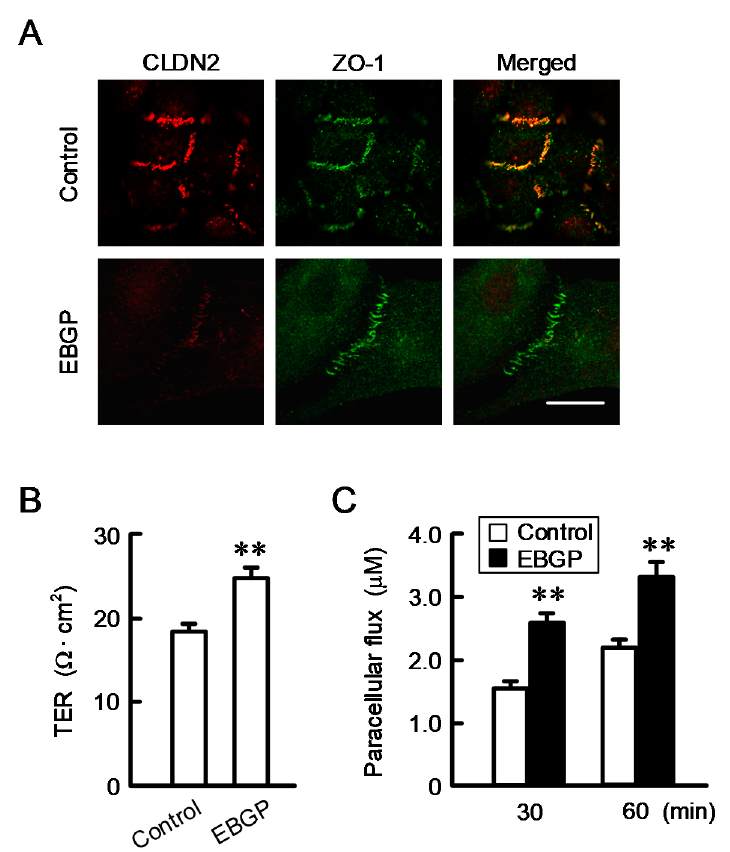
Figure 2. Effect of EBGP on cellular localization of CLDN2 and barrier function. ( A ) Cells cultured on cover glasses were incubated in the absence (control) and presence of 50 μ g/mL EBGP for 24 h. The cells were stained with anti-CLDN2 (red) and anti-zonula occludens-1 (ZO-1) (green) antibodies. Images were taken using the confocal laser microscope equipped with × 100 objective lens. Merged images are shown on the right. Scale bar represents 10 μ m. ( B and C ) Cells cultured on transwell inserts were incubated in the absence and presence of 50 μ g/mL EBGP for 24 h. TER was measured using a volt ohmmeter. Doxorubicin (10 μ M) was added to the apical compartment. After incubation at 4 ° C for 60 min, the solution in the basal compartment was collected, followed by measurement of the fluorescence intensity using an Infinite F200 Pro microplate reader. n = 4. ** p < 0.01 compared with control (Student’s t test).